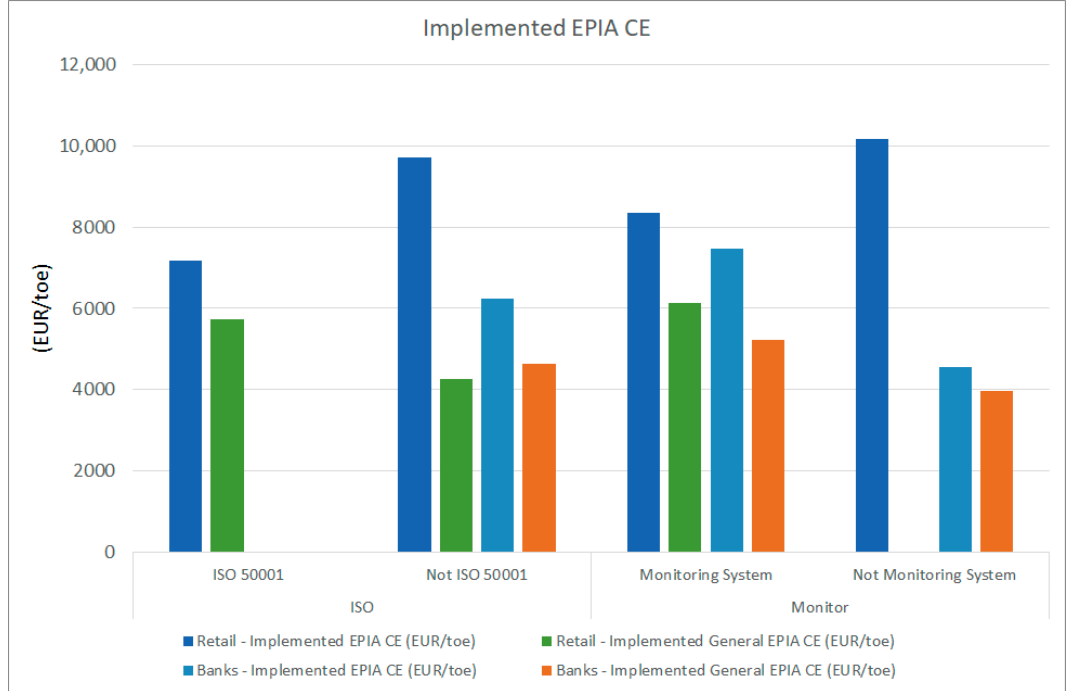
Figure 9. Implemented EPIA cost effectiveness (retail and banks).